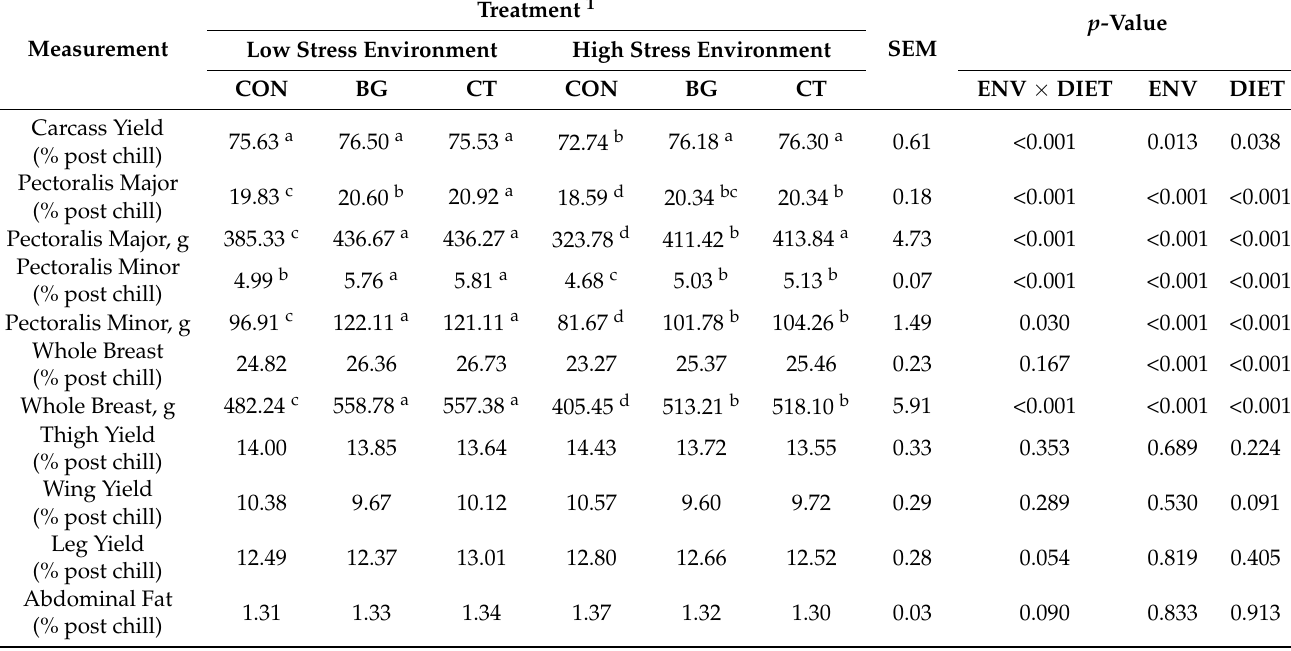
Table 3. Forty-two-day processing yields of birds fed betaGRO and celluTEIN under different environmental